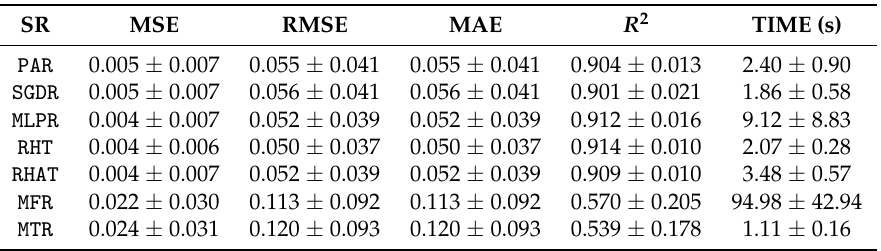
Table 5. Results of the experiment 3: variable selection with a 20% of preparatory instances. Note that RMSE = MAE because all differences are equal.